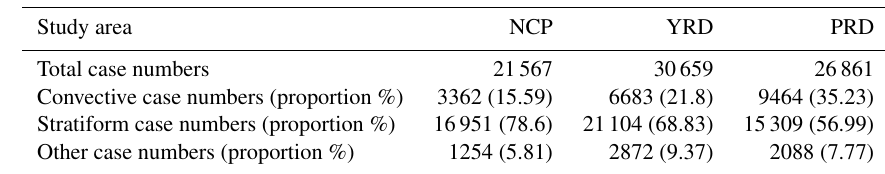
Figure 5. The PDFs of duration of precipitation events (a–c) and PDFs of time difference (in hours) between precipitation peak and start time for all precipitation events (d–f) during the study period of June–August from 2015 to 2020 over the three study regions. The NCP, YRD, and PRD represent the North China Plain, Yangtze River Delta, and Pearl River Delta, respectively. Blue solid lines denote accumulated occurrence frequencies of precipitation (ordinate on the right-hand side of each panel). Red dotted lines and numbers show the accumulated occurrence frequencies of precipitation. Table 1. The number and proportion of different types of precipitation in the three study regions of the North China Plain (NCP), Yangtze River Delta (YRD), and Pearl River Delta